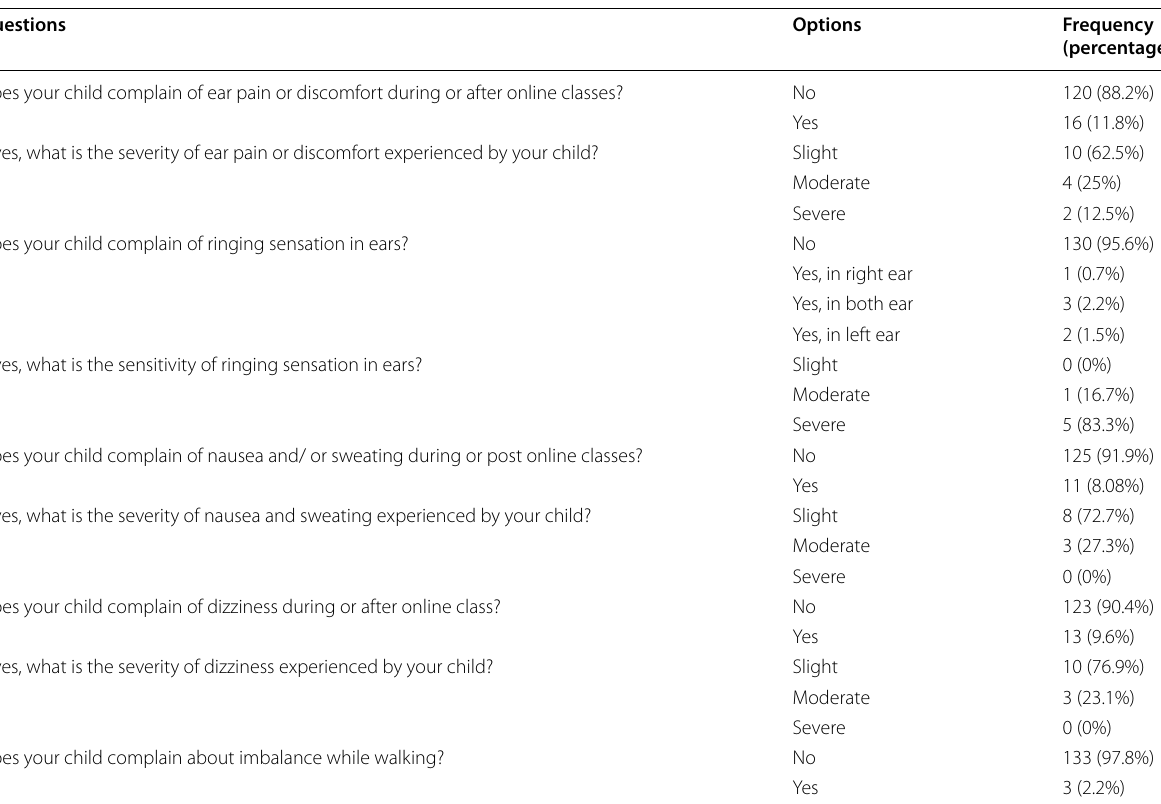
Table 5 Responses to the hearing and balance